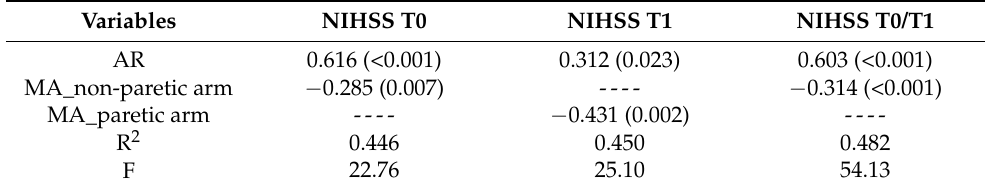
Table 2. Stepwise Multiple Linear Regression Analysis. NIHSST0, NIHSST1 and NIHSST0/T1 as Dependent Variables. Beta Coefficient and P Value.